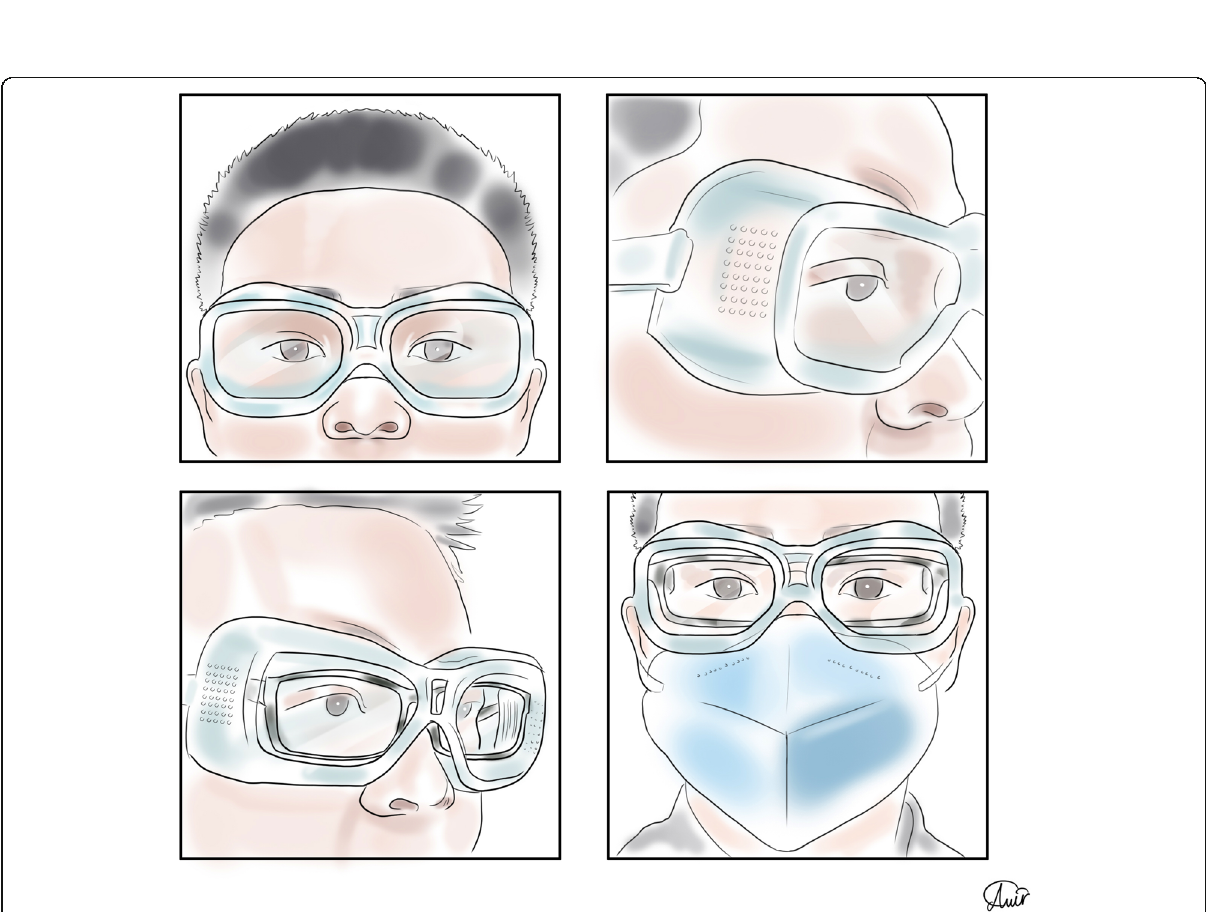
Fig. 7 A proper goggles provide a complete eye